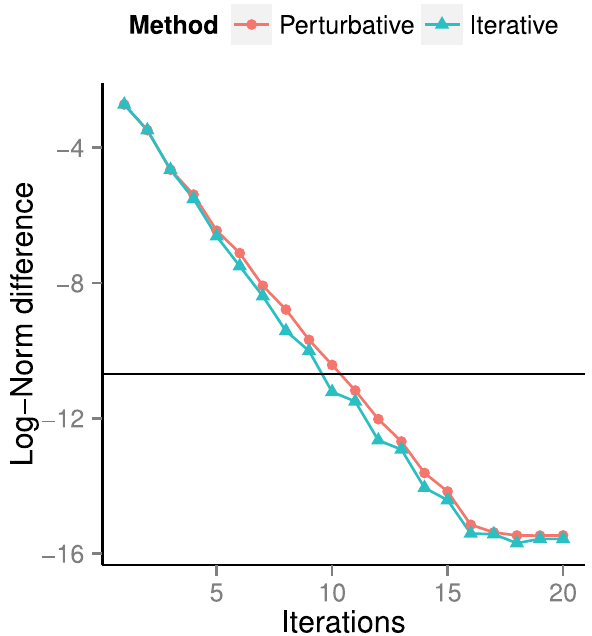
Figure 6. Log of the fixed point error (40) of the perturbative/ iterative solutions after i iterations. Up to iteration 16 , both curves are close to linear with slopes of { 2 : 1407 (perturbative) and { 2 : 2326 (iterative), indicating exponential convergence of both methods. Note that only 10 iterations are required to reach error values corresponding to that of the numerical integrator’s solution.